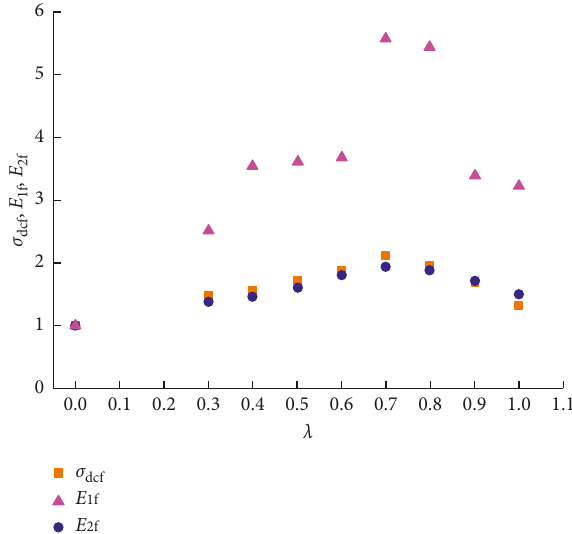
Figure 11: σ dcf , E 1f , and E 2f of artificial frozen silty clay with different axial compressive stress